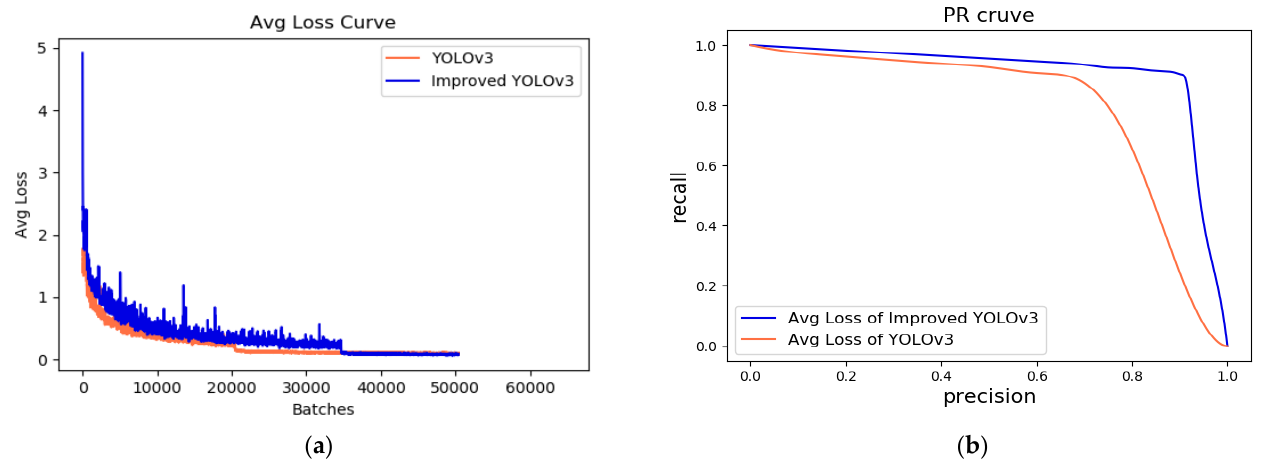
Figure 6. The comparison of the ( a ) Avg Loss Curve and ( b ) P-R Curve between YOLOv3 and improved YOLOv3. Table 2. Comparisons of YOLOv3 Detection Results before and after Improvements (mAP@0.5). Detection Algorithm